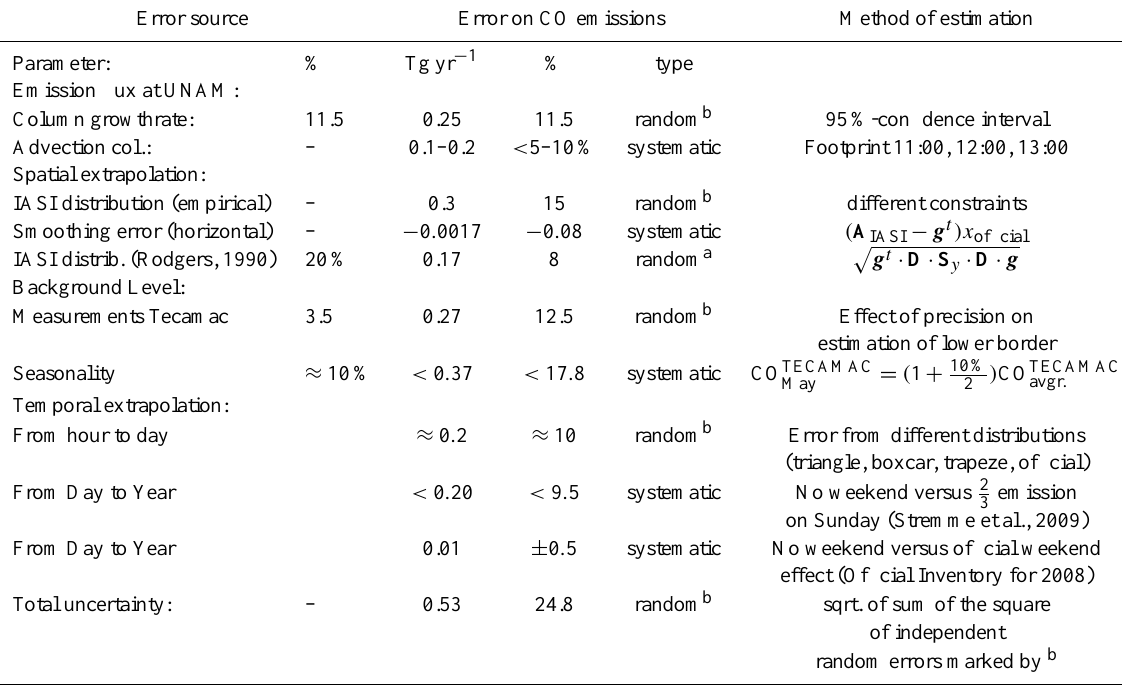
Table 3. Summary of errors for the total CO emission estimation in the MCMA.